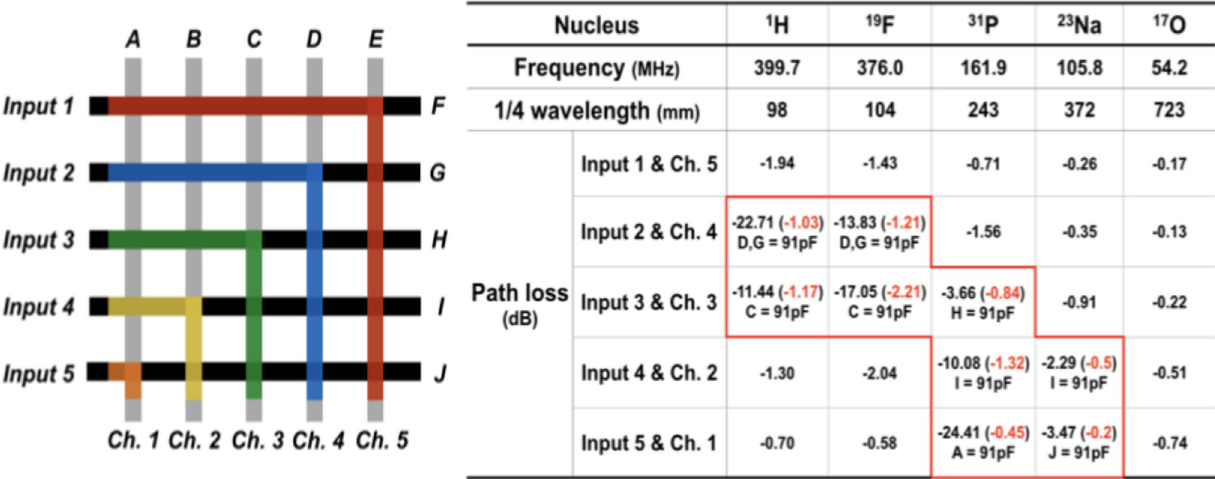
Fig 2. Signal routes (colored) evaluated at different frequencies (left) and insertion loss measured on the bench for the different nuclei considered here. If the insertion loss was above 2 dB, a single value compensation (91 pF) was attached at one or both transmission lines and the insertion loss re- measured for all possible combination of compensation elements. All values are in dB; all input lines are designated as “Input” and all output lines as “Channel” with consecutive numbering. Transmission line stubs are labeled with alphabetical capital letters A to J. For the sake of clarity, only a limited number of matrix configurations have been evaluated experimentally, e.g. the switch was configured with fixed connections from input #1 to output #5, input #2 to output #4 and so forth to demonstrate the effect of transmission line stubs of different length for different resonant frequencies. In the table on the right, the value for the insertion loss shown in black indicates values measured for the unterminated case (that is, without the 91 pF attached to the transmission line stub). Red values are the ones representing IL for the terminated case (where the 91 pF are connected to the transmission line stubs). For the terminated case, the location of the termination capacitance is given underneath the measured IL values.